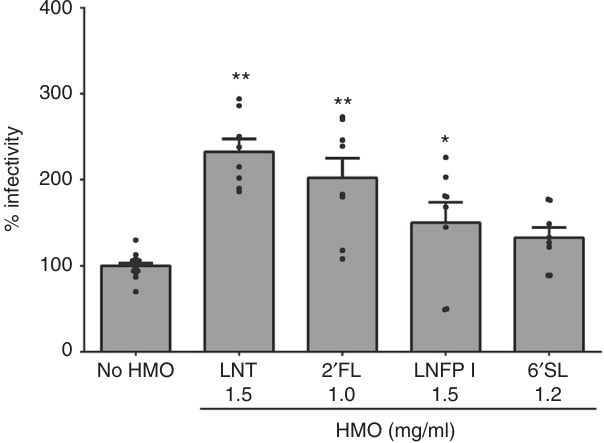
Fig. 6 Speci fi c HMOs enhance the infectivity of a P[11] rotavirus vaccine. HMOs 2 ’ FL and LNT enhance the infectivity of Rotavac ® in MA104 cells. All bars represent the mean percentage of infectivity with error bars denoting standard error of the mean from a minimum of three independent experiments. No HMO treatment was considered 100% infectivity. The mean baseline titer of Rotavac ® (100% infectivity) was 7.3 × 10 5 fl uorescent focus units (FFU) per ml. p value <0.05 (analysis of variance with Dunnett ’ s post hoc test) was considered statistically signi fi cant (* p < 0.05, ** p <